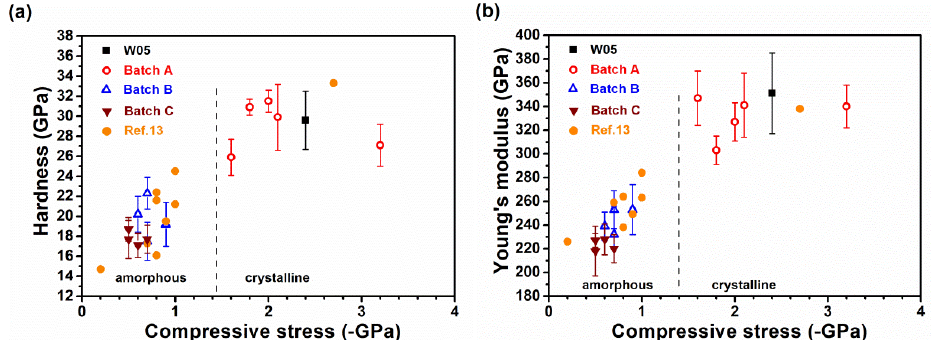
Figure 7. Relationships between ( a ) H and ( b ) E and residual stress of W–N and W–Si–N films.